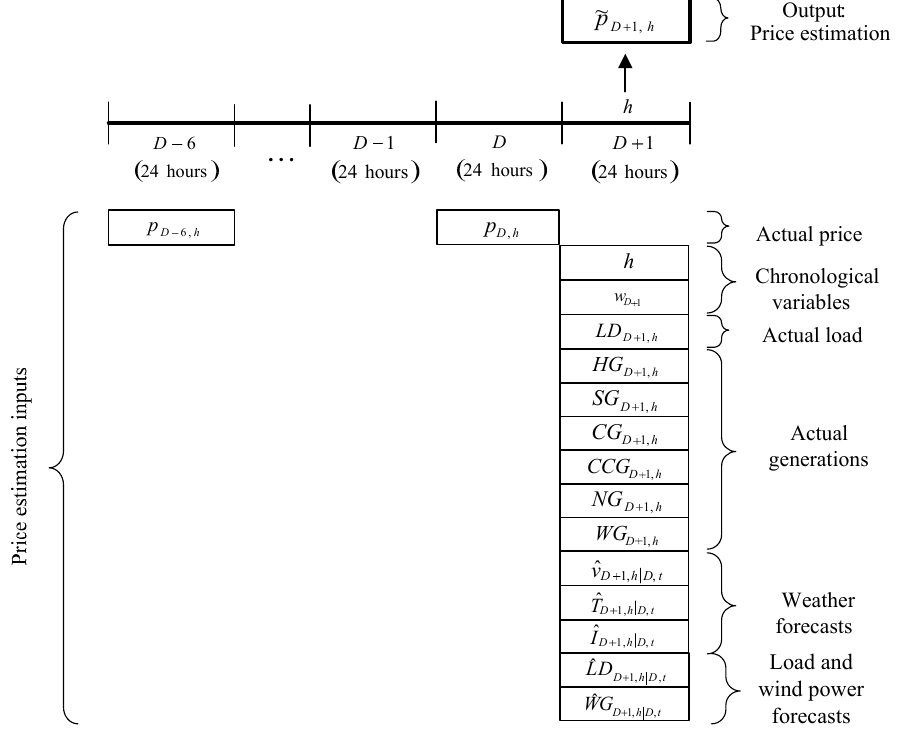
Figure 2. Time framework of reference models for price estimation (RMPE models).